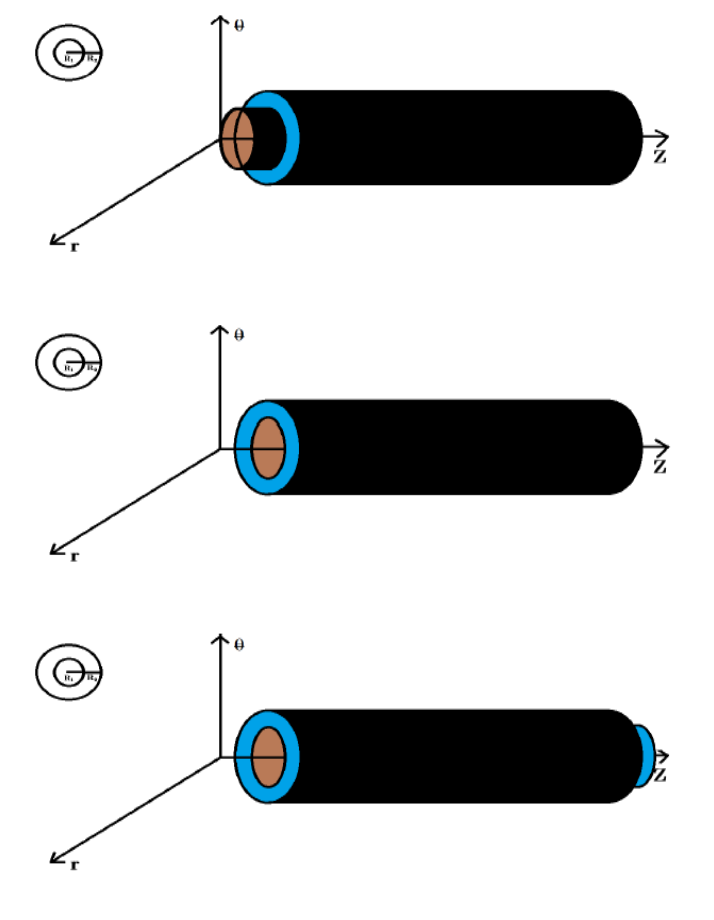
Figure 1. Geometry of the